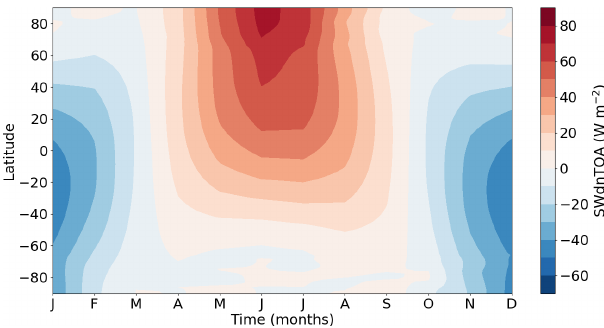
Figure 1. Annual cycle of the insolation LIG–PI anomaly (Wm − 2 ) as a function of latitudes. The LIG insolation is computed using the celestial calendar with the vernal equinox on 21 March at